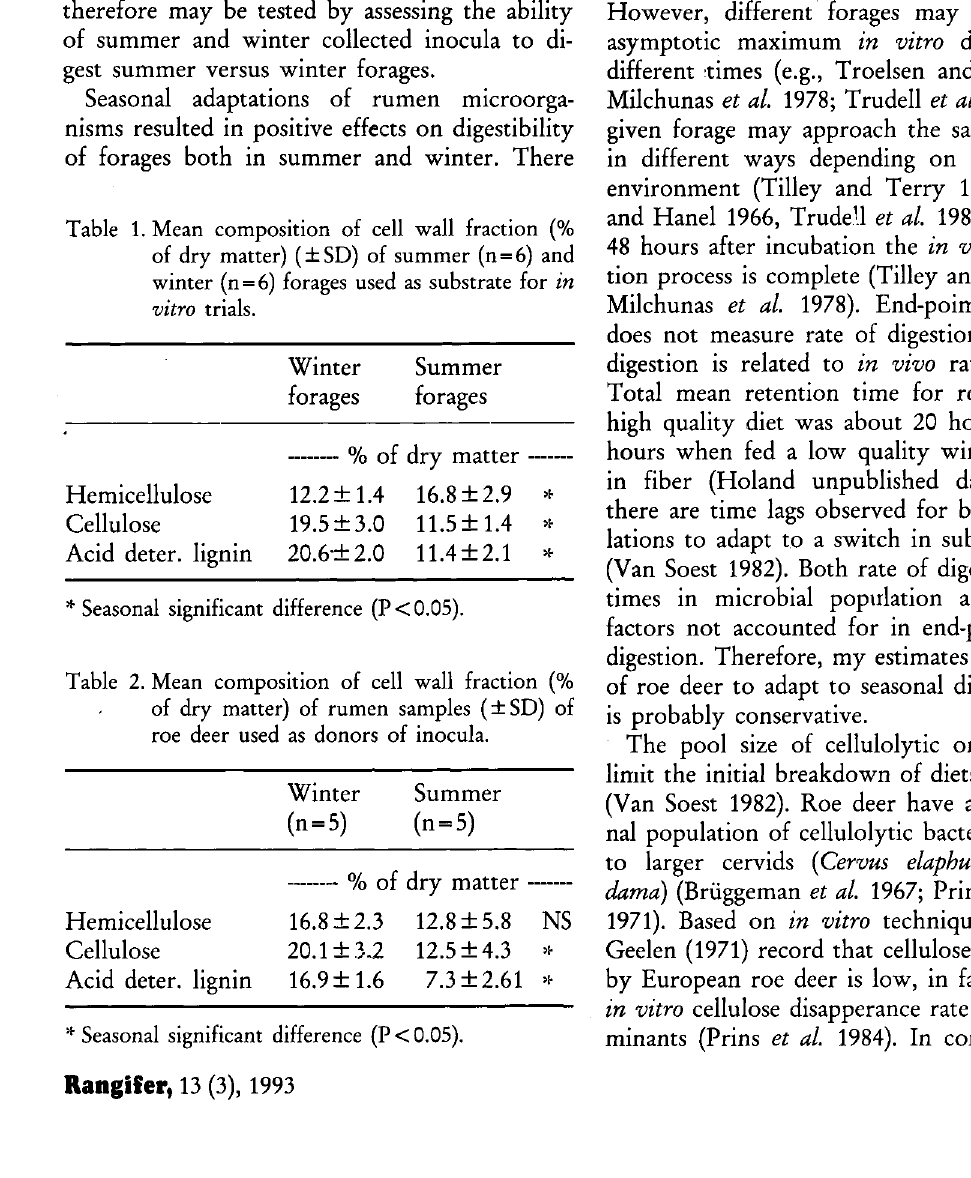
Table 2. Mean composition of cell wall fraction (% of dry matter) of rumen samples (±SD) of roe deer used as donors of